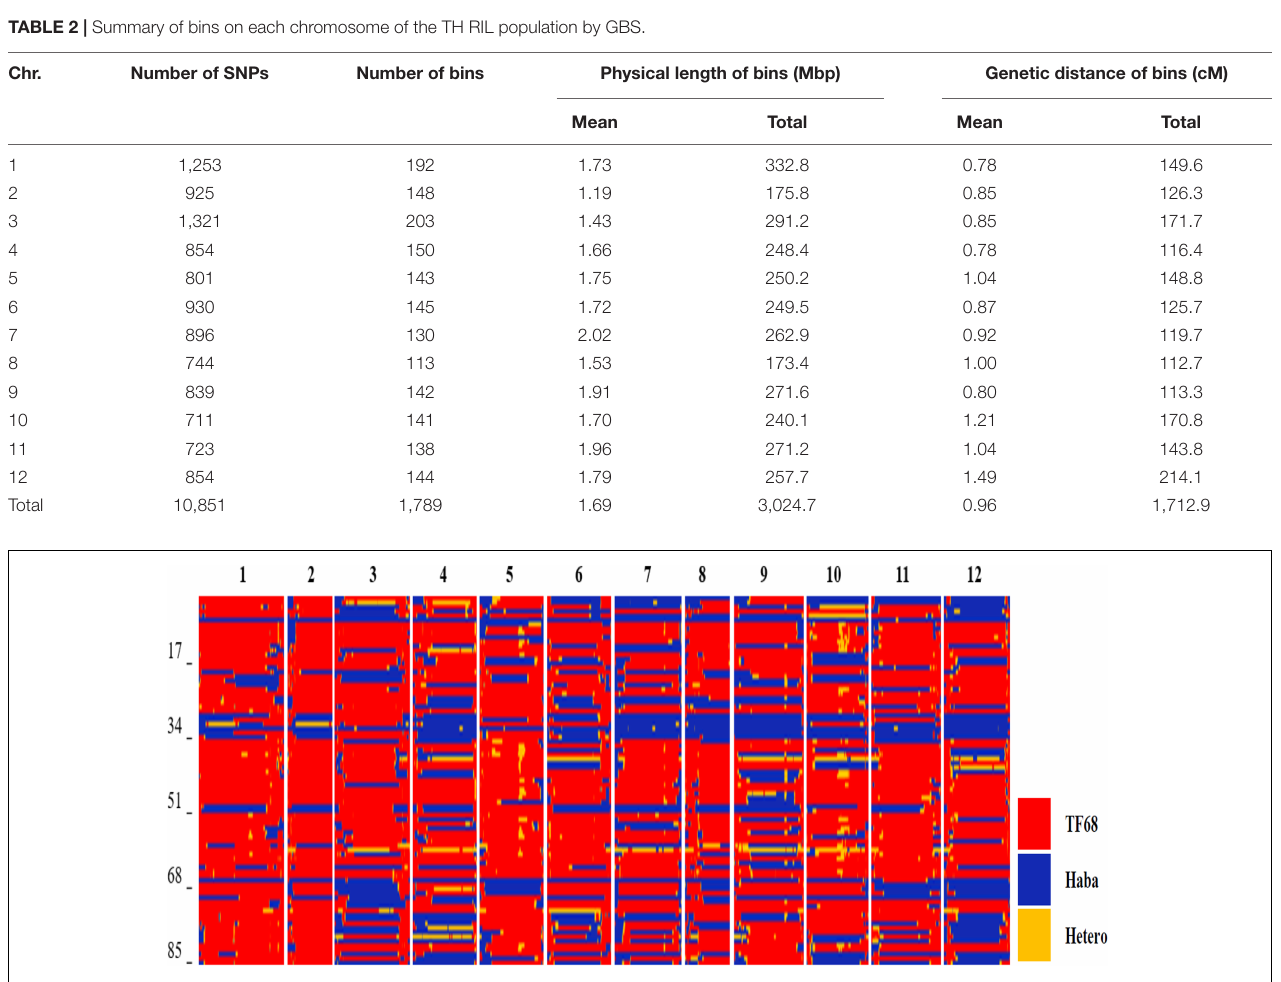
FIGURE 2 | Bin map of the TH RIL population. Red indicates regions with a TF68-type genotype, blue represents Habanero-type genomic regions, and yellow denotes heterozygous regions.